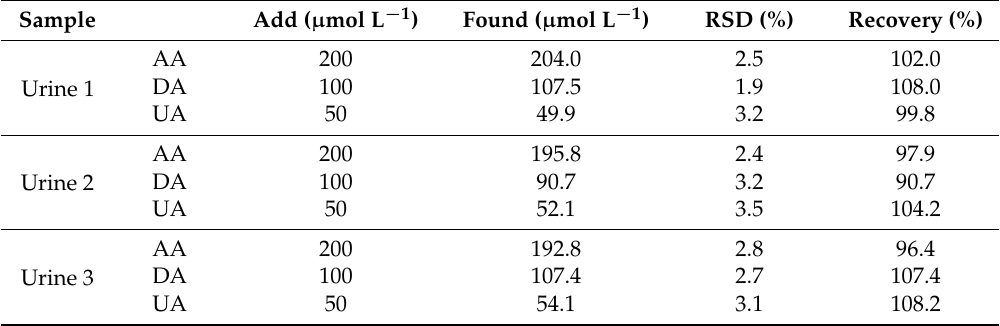
Table 2. Determination of AA, DA, and UA in human urine samples (n =